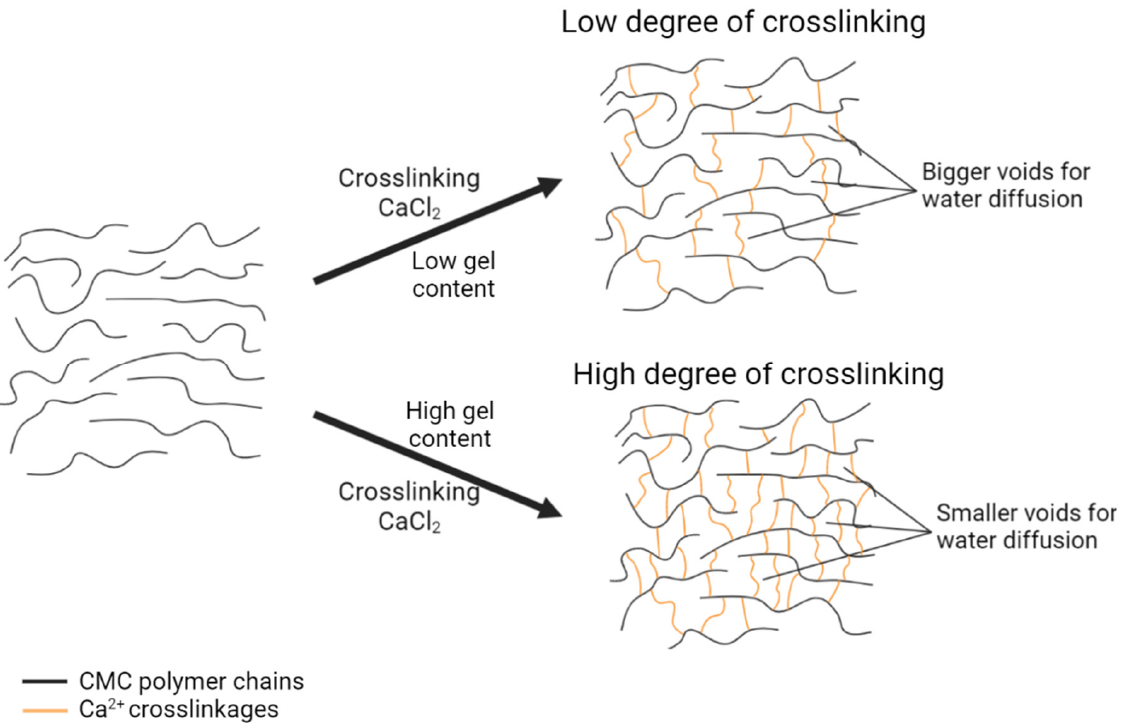
Figure 5. Schematic illustration of CMC–CaCl 2 hydrogel with different degrees of crosslinking.